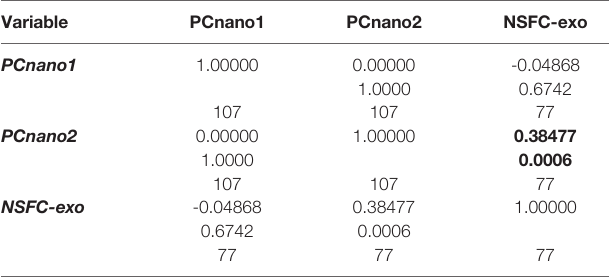
TABLE 3 | Descriptive and inferential statistics of the two patient groups (PCa and CTR) as for the two main principal components of NTA derived descriptors. Variable